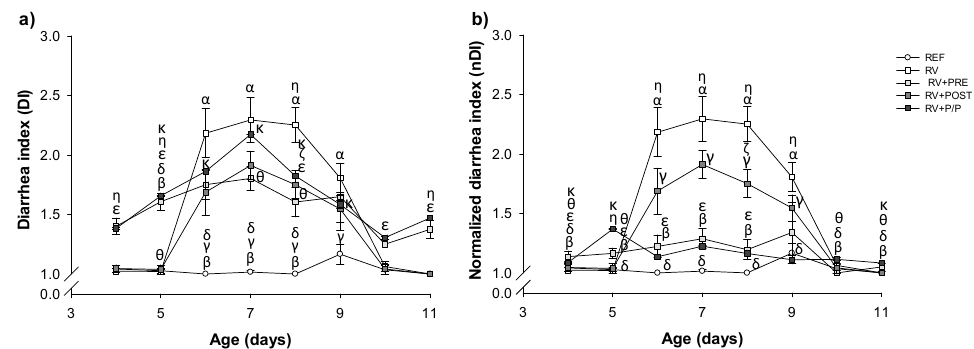
Figure 3. Severity of diarrhea from day 4 to day 11 by two approaches: non-normalized results ( a ) and normalized results ( b ). Results are expressed as mean ± SEM ( n = 24 animals/group). Statistical significance: α p < 0.05 RV vs. REF, β RV + PRE vs. REF, γ RV + POST vs. REF, δ RV + P/P vs. REF, ε RV + PRE vs. RV, ζ RV + POST vs. RV, η RV + P/P vs. RV, θ RV + POST vs. RV + PRE, κ RV + P/P vs. RV + POST, and RV + POST vs. RV + P/P. REF: reference group; RV: rotavirus group; RV + PRE: rotavirus group supplemented with a mixture of scGOS/lcFOS; RV + POST: rotavirus group supplemented with Lactofidus TM ; RV + P/P: rotavirus group supple- mented with the combination of both.